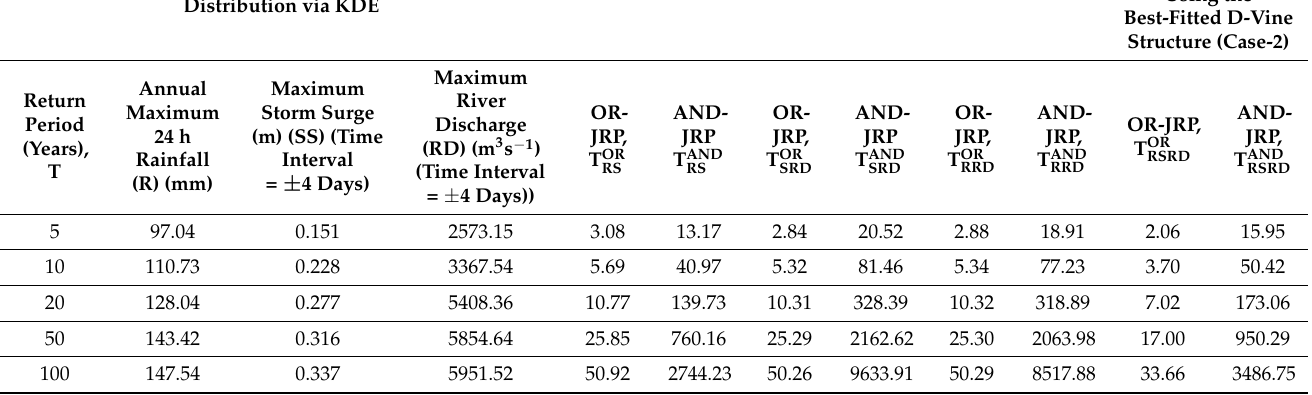
Table 9. Comparing primary return periods (univariate vs. bivariate vs. trivariate) for a different possible combination of triplet flood